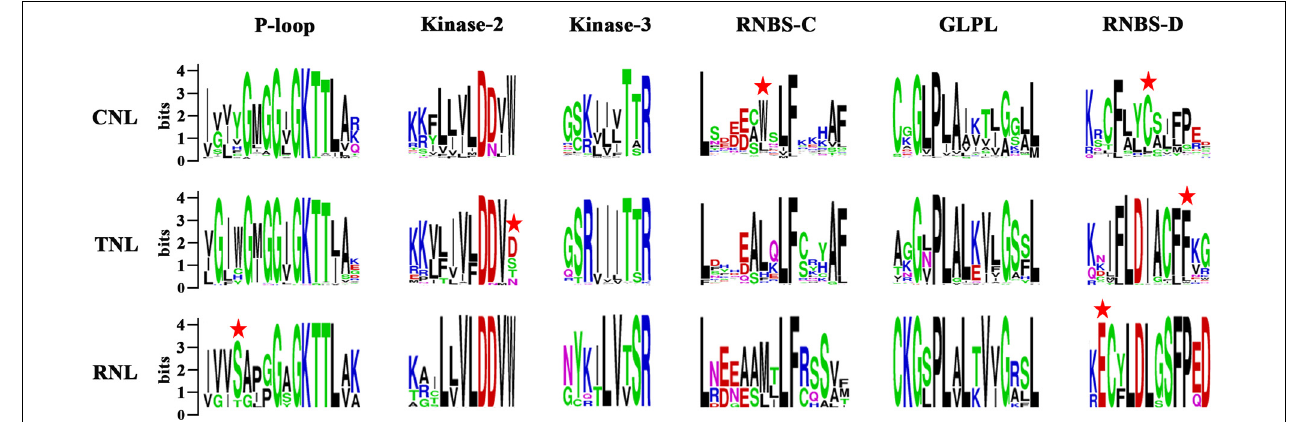
FIGURE 1 | Six conserved motifs of NBS domains in the three Sapindaceae species. Amino acids of the six conserved motifs were extracted. Different conserved amino acids among CNL, TNL, and RNL subclass genes are labeled with a red star. Details of the amino acids of the whole NBS domain are presented in Supplementary Figure S2 .